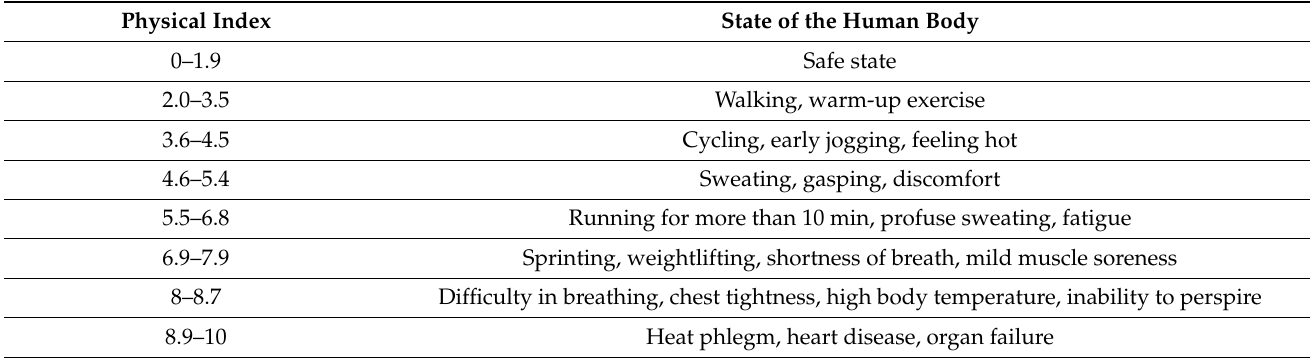
Table 5. Physical fitness status